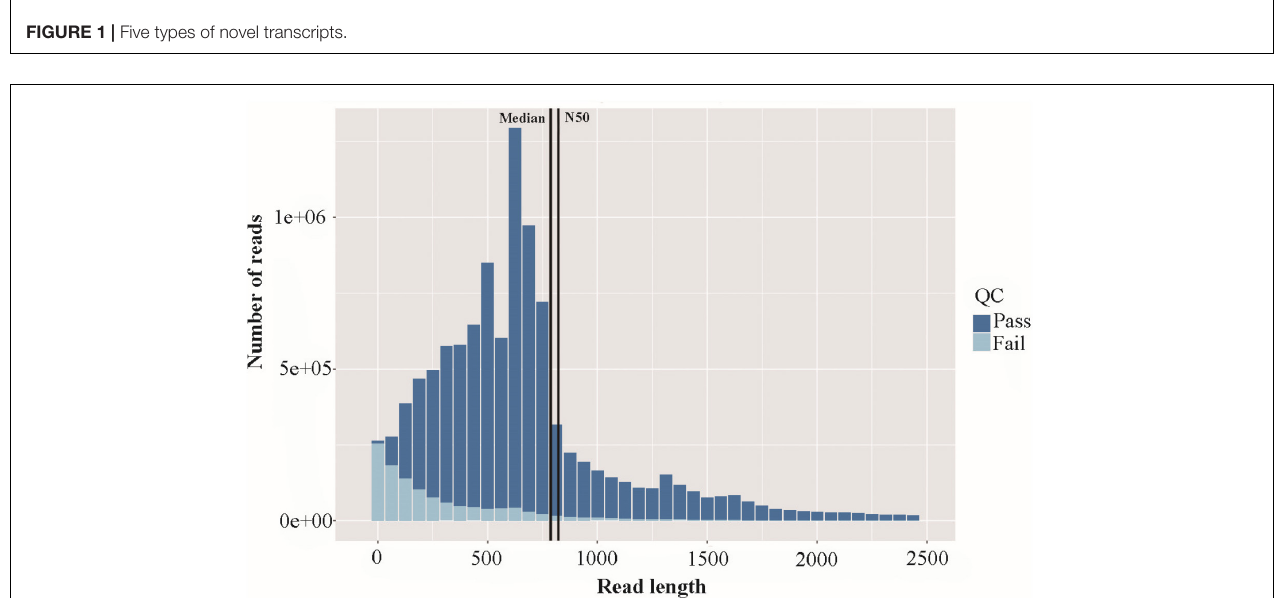
FIGURE 1 | Five types of novel transcripts.